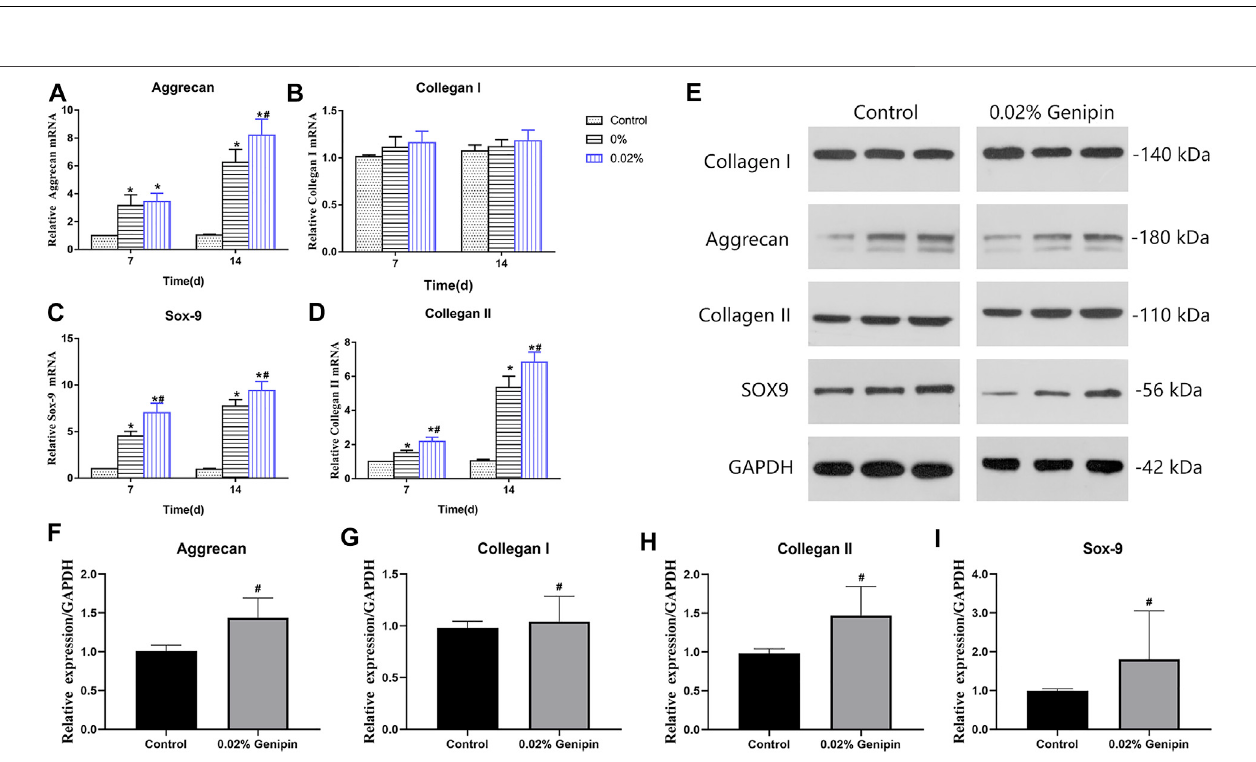
FIGURE 4 | Cytocompatibility measurement of the hydrogels in vitro . (A – E) Live/dead cell staining and cell morphology observed at 5 days in the 2D-cultured control group and 0%, 0.01%, 0.02%, and 0.04% groups; (F) the living cell ratio showing the viability of cells; (G) the cell proliferation tested by the CCK-8 test. Data represented mean ± SD ( n (cid:2) 5); * p < 0.05, vs. 0% group; # p < 0.05, vs. 0.1% group; & p < 0.05, vs. 0.02% group. Scale bar (cid:2) 100 μ m.